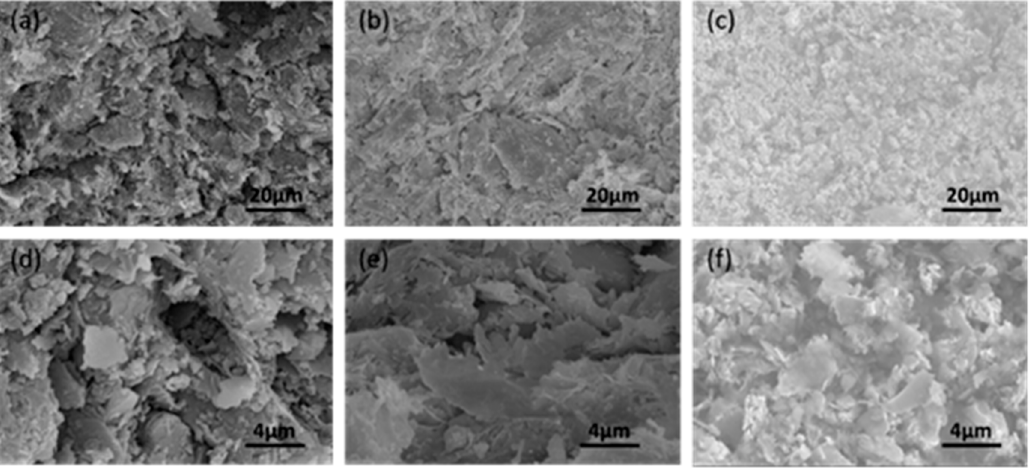
Figure 5. SEM images of clay and conductive graphene clay bricks (CGCB): ( a ) the reference, 1000×; ( b ) 0.7 wt.% GO, 1000×; ( c ) 5 wt.% GO, 1000×; ( d ) the reference, 5000×; ( e ) 0.7 wt.% GO, 5000×; ( f ) 5 wt.% GO, 5000×.